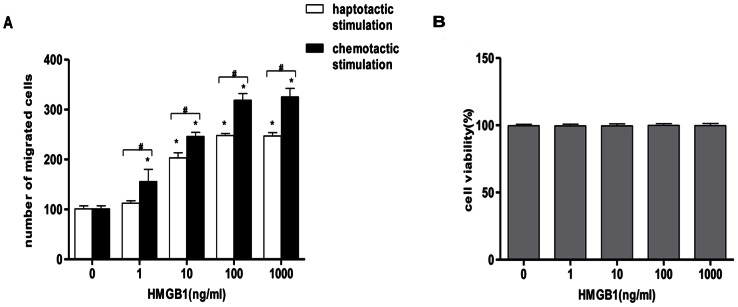
HMGB1 promoted the migration of primary human HSCs.(A) HMGB1 was either added to the upper transwell chamber containing the cells (haptotactic stimulation) or to the lower chamber not containing cells (chemotactic stimulation). HMGB1 promoted the migration of primary human HSCs by both chemotactic and haptotactic mechanisms. Data are expressed as the mean ± SEM (n = 6). *P<0.05, compared to 0 ng/ml group; #P<0.05, chemotactic stimulation compared to the haptotactic stimulation in the same concentration. (B) HMGB1 did not cause any cytotoxic effects. Cell viability was detected by trypan blue staining. Data are expressed as mean ± SEM (n = 6).